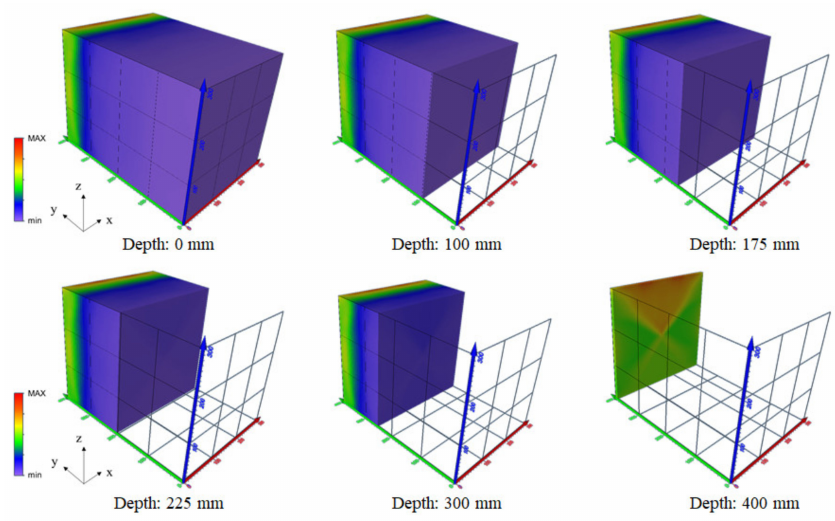
Figure 21. Improved 3D SIBIE results for damage-simulated concrete specimen.